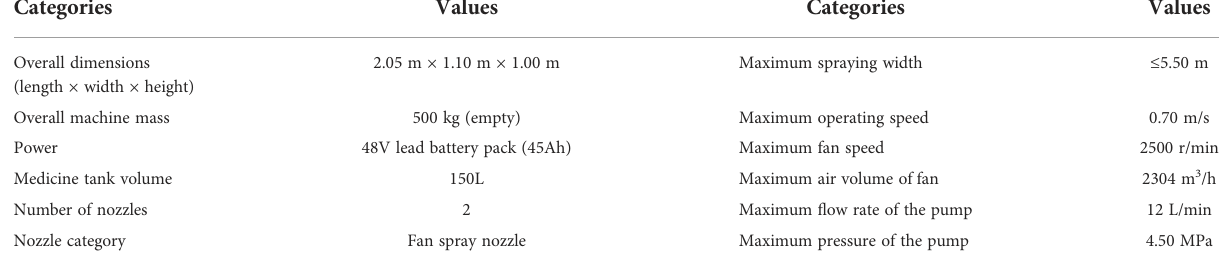
TABLE 2 The main parameters of the small swing-arm sprayer.